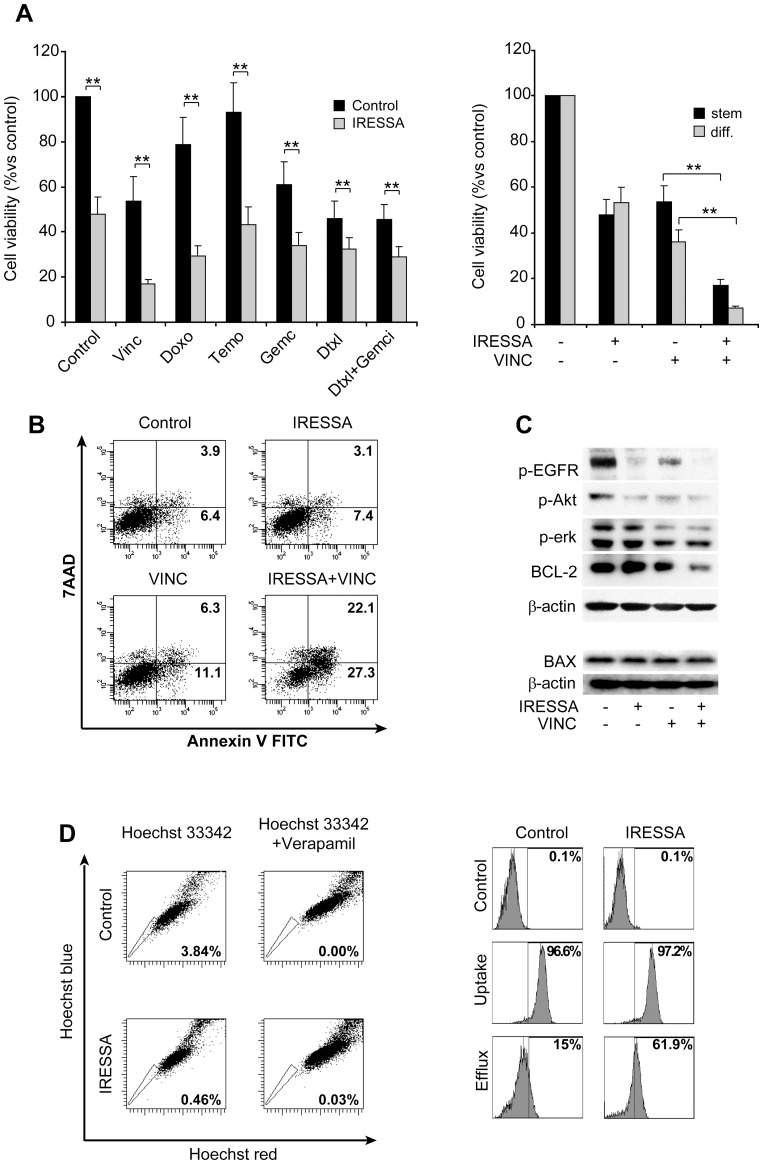
IRESSA treatment reduces LMS stem-like cell growth rate and sensitizes them to chemotherapy.A) Effect of IRESSA on LMS cell chemo-sensitivity. (Left) Stem-like cells were exposed to IRESSA and the indicated compounds and cell viability was evaluated after 72 hours by Cell Titer Glo assay (Promega). (Right) Cell viability of undifferentiated (stem) or differentiated (diff) LMS cells exposed to IRESSA/vincristine combination for 72 hours. Mean ± SD of 3 independent experiments is shown. ** p<0,01. B) Flow cytometric analysis for Annexin V of LMS stem-like cells untreated (control) or treated as indicated. C) Immunoblot for the indicated proteins or phosphoproteins of LMS stem-like cells left untreated or treated as indicated. D) Effect of IRESSA on SP and drug efflux ability. (Left) SP analysis of control or IRESSA-treated LMS stem-like cells. (Right) Cytoﬂuorimetric profiles of control or IRESSA treated LMS stem-like cells after exposure to doxorubicin (Uptake), or after drug treatment followed by removal and overnight incubation in drug-free medium (Efﬂux).